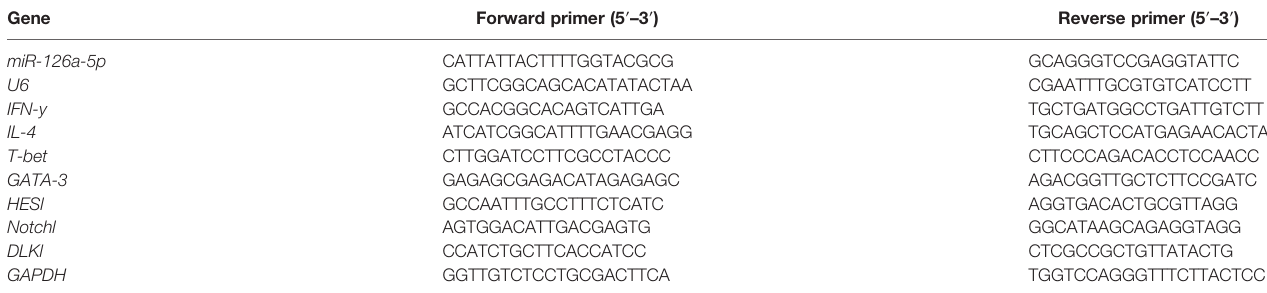
TABLE 1 | Sequences of primers involved in